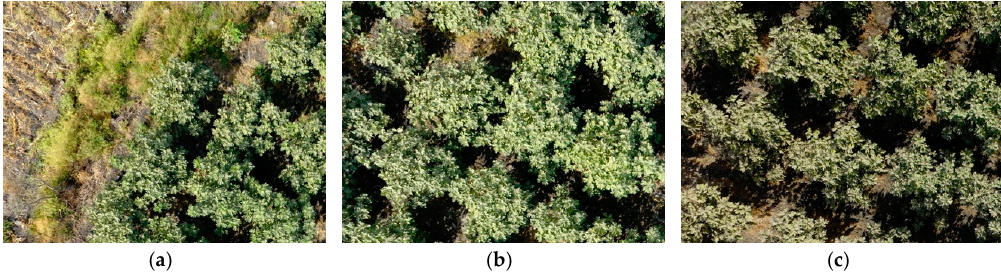
Table 4. Colour vegetation indices formulas.